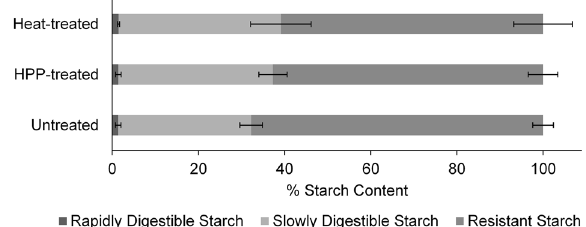
Fig. 7 Average percent rapidly digestible, slowly digestible, and resistant starch content based on dynamic digestions of pea protein concentrate with 15% (w/w) protein (15 P). The percent of glucose released from starch during the fi rst 20 and 20 – 120 min of dynamic digestion was categorized as rapidly digestible and slowly digestible starch, respectively. The remaining starch that did not break down to glucose after 120 min of dynamic digestion was deemed resistant starch 68 . The glucose assay was performed on each independent replicate of digestions in technical duplicate, where the percent starch content for each independent digestion was an average of the technical duplicates. Bars represent the average percent starch content for the three independent diges- tions. Error bars display the standard deviation. Statistical compar- isons of starch content by treatment type were not signi fi cant ( p <